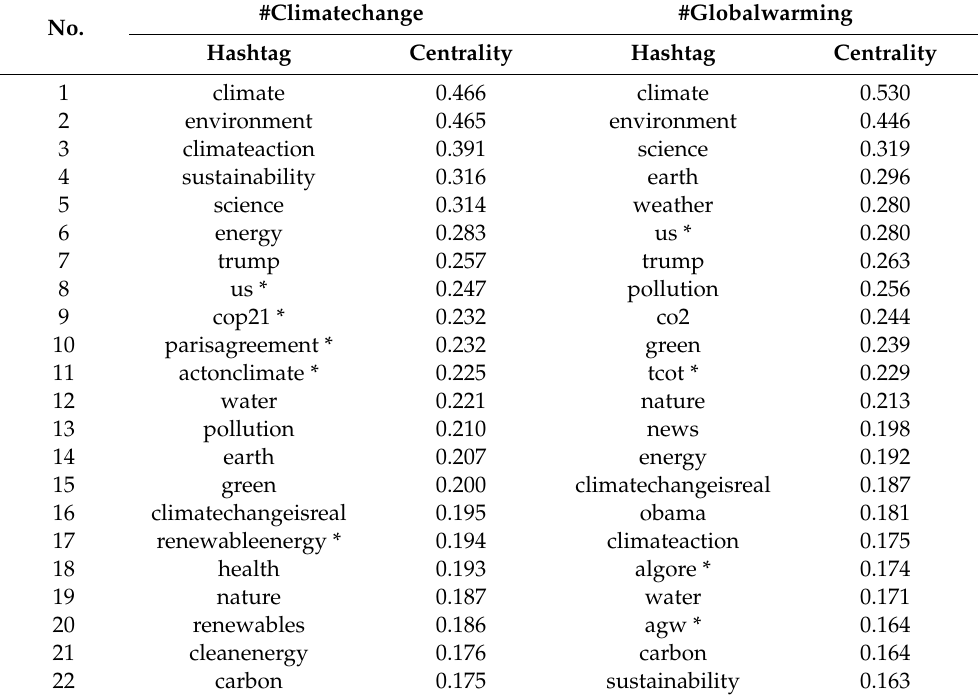
Table 1. The top 50 central hashtags on Twitter surrounding #climatechange and #globalwarming from 2009 to 2018. The hashtag with * is explained in Appendix A in ascending alphabetical